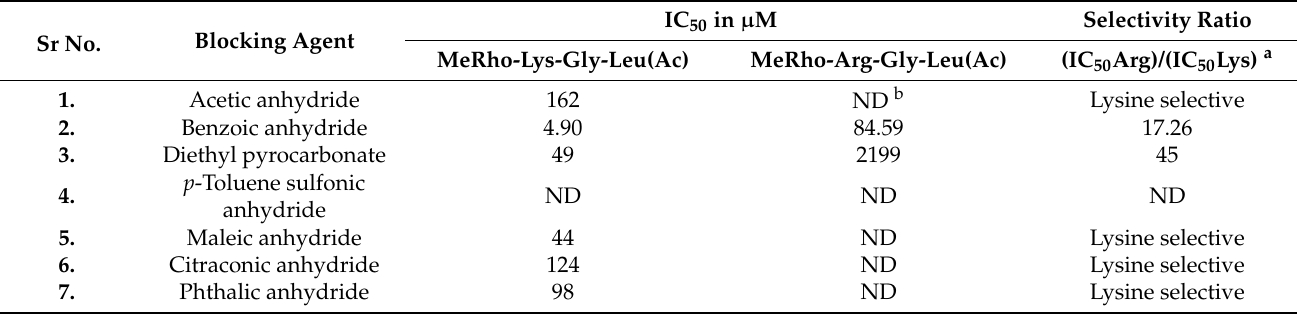
Figure 5. Trypsin concentration-dependent kinetic study of the reaction between a peptide substrate and trypsin. ( A ) Kinetic study of the reaction between MeRho-Lys-Gly-Leu(Ac) and trypsin (0.025, 0.1, 0.25, 1, 2.5, 10, and 25 µ g/ mL); ( B ) kinetic study of the reaction between MeRho-Lys-Gly-Leu(Ac) and trypsin (0.25, 0.45, 0.65, 0.85, and 1 µg/mL); ( C ) kinetic study of the reaction between MeRho-Arg-Gly-Leu(Ac) and trypsin (0.025, 0.1, 0.25, 1, 2.5, 10, and 25 µg/mL); ( D ) kinetic study of the reaction between MeRho-Arg-Gly-Leu(Ac) and trypsin (0.25, 0.45, 0.65, 0.85, and 1 µg/ mL); ( E ) calibration curve for concentrations of 0.005, 0.01, 0.02, 0.05, 0.1, 0.2, 0.5, and 1.0 µM of the MeRho fluorophore standard; ( F ) calculated concentrations of the MeRho fluorophore released from fluorogenic peptide substrate probes during the trypsin-mediated proteolytic reaction. Table 1. The selectivity of blocking agents for